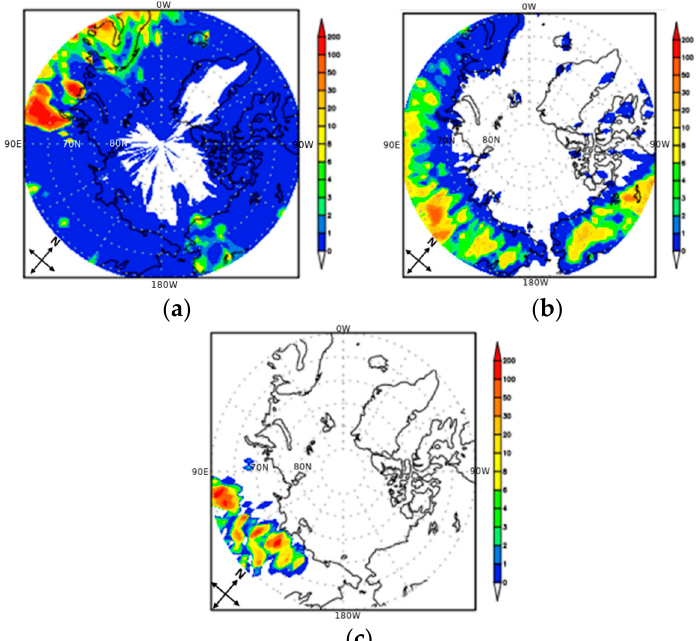
Figure 1. The average annual anthropogenic component of BC emission rate (mg/m 2 per year) for the period 1985–2014 ( а ); average annual emission rate from biomass combustion for the period 1985–2014 ( b ), total emissions as a result of forest fires in Siberia in 2019 according to IGCE data ( c ).